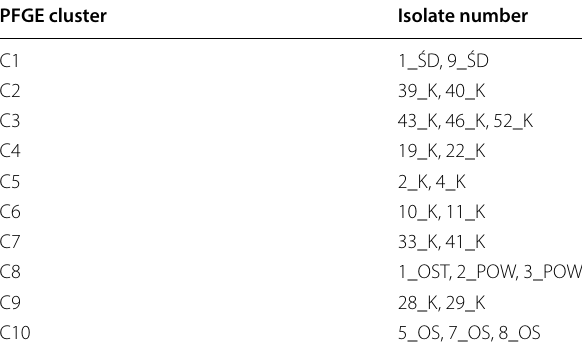
Table 2 The cluster of genetic similarity determined for tested strains at cut-off level of 80%